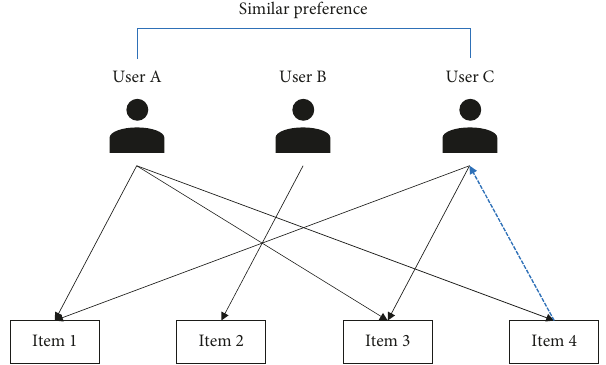
Figure 5: Principle of user-based collaborative filtering recommendation.